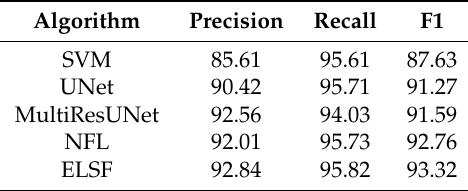
Figure 16. F1-score comparison between di ff erent algorithms. (Each point within a scatterplot figure represents the F1-score of a test sample using ELSF and a comparison algorithm. The point within the green circle represents a testing sample coming from the eastern coast of Brazil, a region that does not appear in the training set). Table 4. Comparison of segmentation among di ff erent